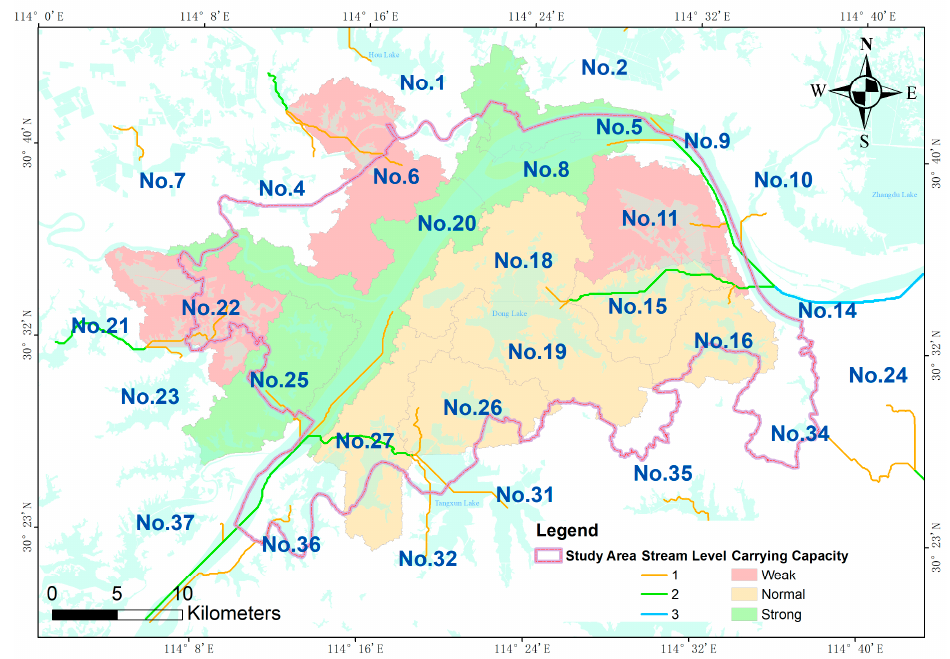
Figure 4. The flood-carrying ability of each catchment. The flood-carrying capacity is derived from the storing ability, the receiving ability, the drainage potential, and the pumping outward emergency.